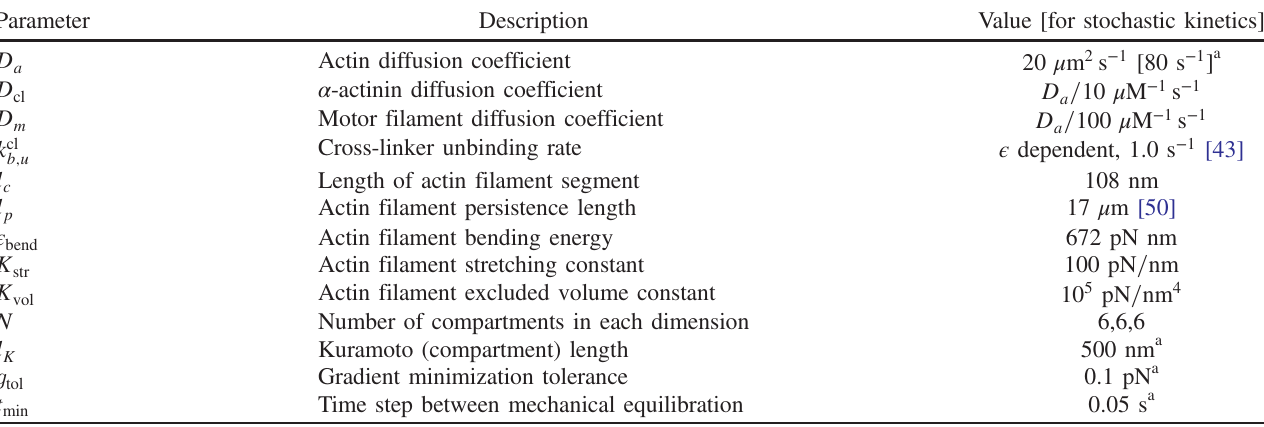
TABLE II. Model parameters chosen to mimic a typical system of actin filaments, cross-linkers, and nonmuscle myosin IIA motor filaments in three-dimensional MEDYAN simulations of an actomyosin force dipole. All other parameters and models used in the one- dimensional stochastic “ toy ” representation, but not included in this table, are directly implemented as in the previous model. This includes motor and cross-linker